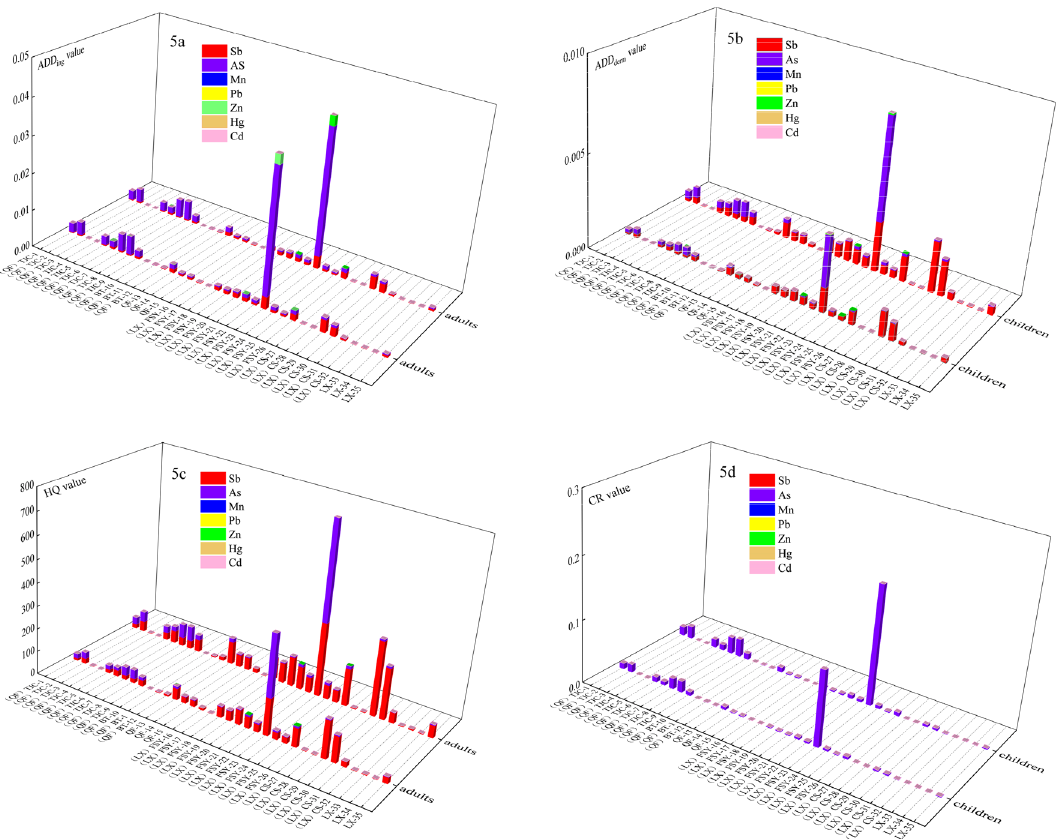
Figure 5. ( a and b ) ADD, ( c ) HI and ( d ) CR for metals in the surface water in XKS through ingestion and skin contacting for adults and